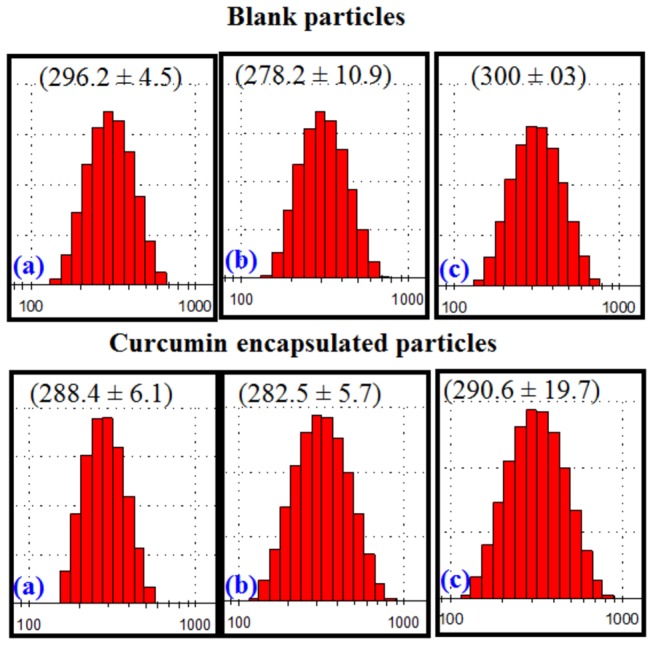
Particle characteristics measured by Malvern zeta sizer fresh (A) after centrifugation (B) and after freeze drying (C).The numbers in parenthesis are average particle size in nm.